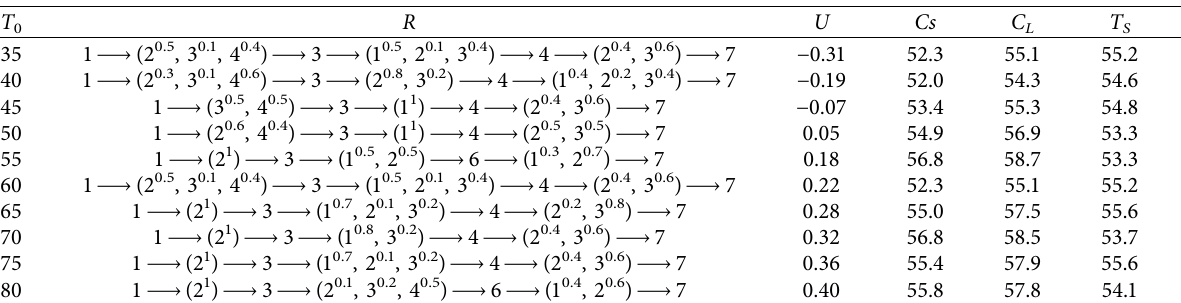
Table 4: The impact of T 0 on transportation plans.